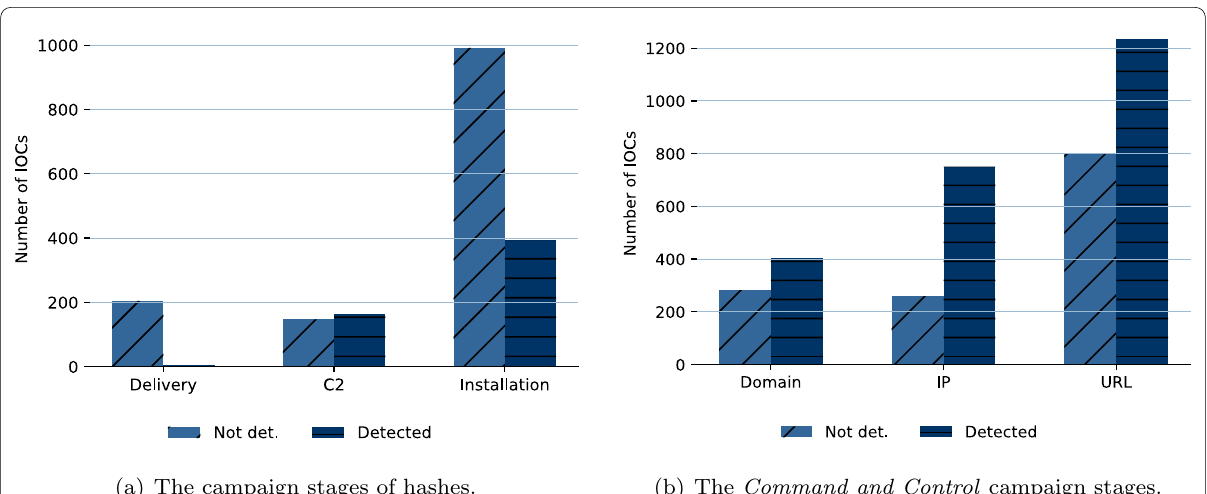
(a) The campaign stages of hashes. (b) The Command and Control campaign stages. Fig. 9 The verification (using the VirusTotal analysis) for Delivery , Installation , and Command and Control campaign stages of the hash, as well as the Command and Control campaign stages of the domain, IP, and URL discovered from TriCTI. Note: Not det. indicates that the IOCs are found in VT but there are not existing any kind of malicious Relationships to indicate their campaign stages, and Detected represents the number of the IOCs that are found in VT and have at least one malicious Relationships